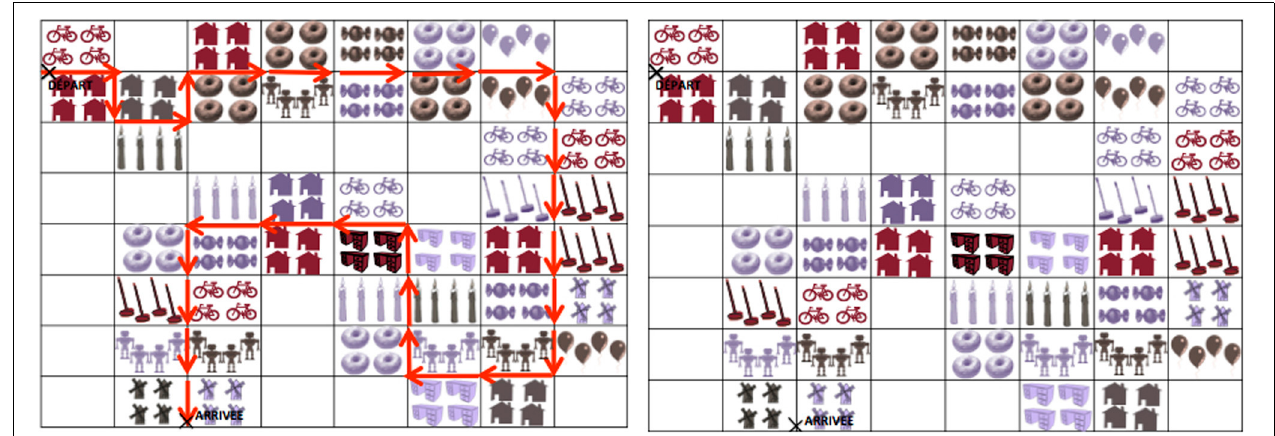
FIGURE 1 | Maps used for the experiment; the director’s map includes the route (left panel) while the follower’s map does not include it (right